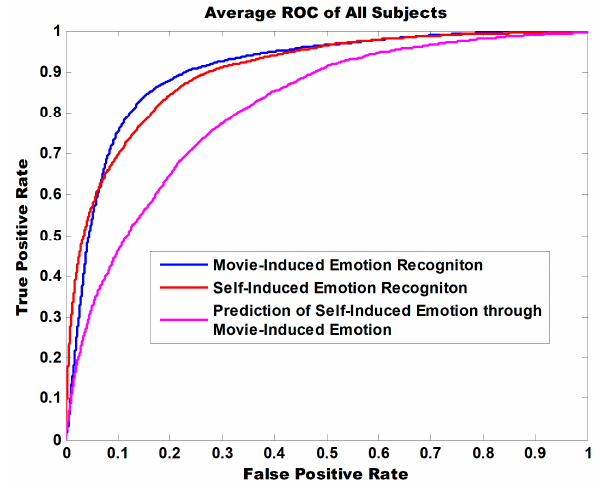
Figure 9. ROC curve of binary emotional classification in three experiment tasks. Positive emotions are distinguished from negative emotions. The AUC values of binary classification for movie-induced emotion recognition, self-induced emotion recognition, and prediction of self-induced emotion through movie-induced emotion are 0.9047, 0.8996, and 0.8102, respectively. Table 5. Performance of binary classification for the discrimination of positive emotions from negative emotions (Standard deviations are shown in parentheses).